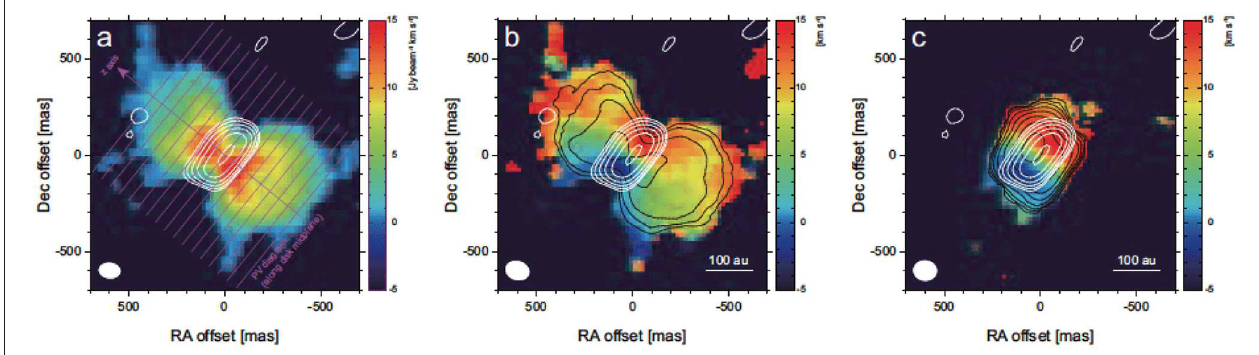
FIGURE 1 | ALMA observations of rotation in the bipolar outflow driven by Orion Source I, a high mass YSO candidate. White contours are 490 GHz continuum maps. (a) moment 0 (color; integrated intensity) map of 484 GHz emission in Si 18 O; (b) moment 0 (black contours) and moment 1 (peak velocity; color) map of the 484 GHz Si18O line; (c) moment 0 (black) and moment 1 (color) maps of the 463 GHz H2O line. These latter two plots show rotational velocity gradients of the outflow- water line emission being more compact. From Hirota et al. (2017) reproduced with permission c